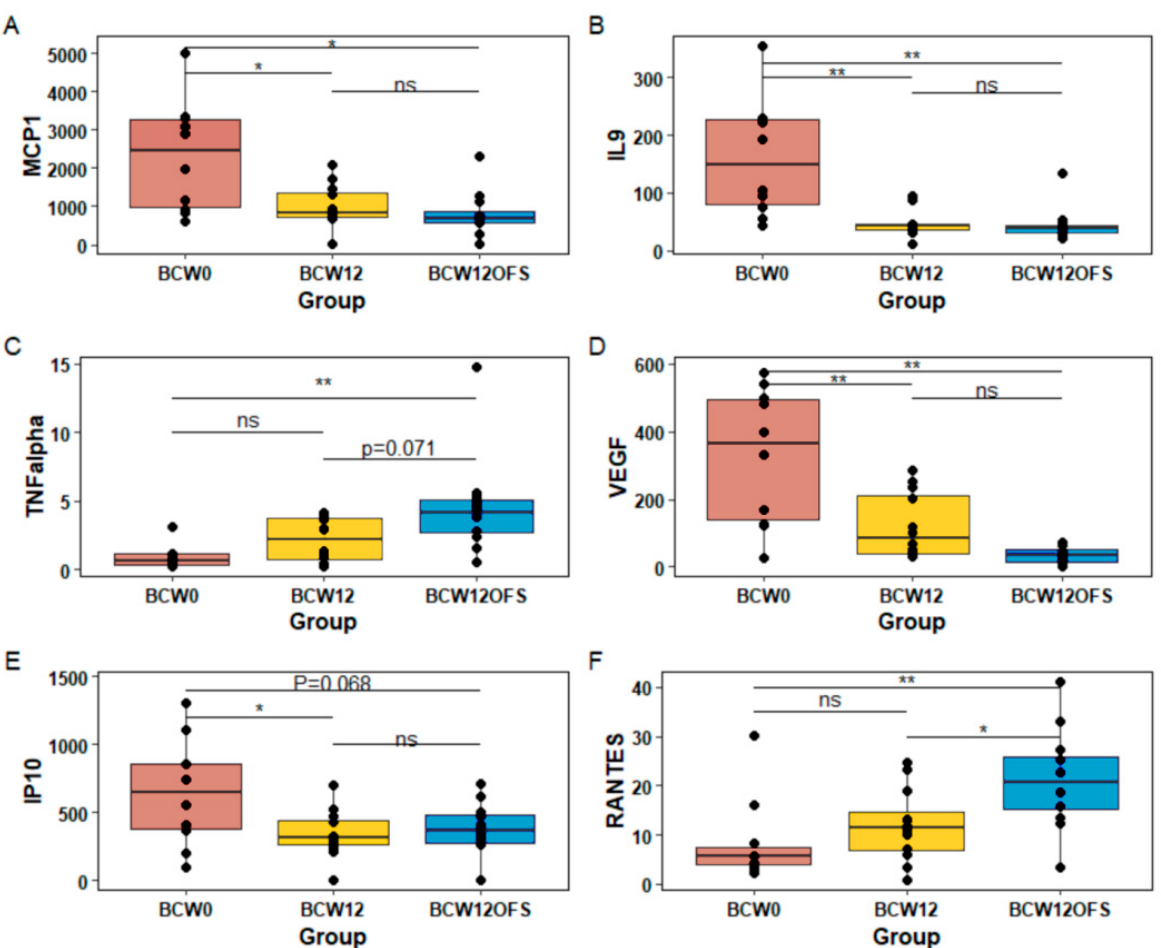
Figure 11. Levels of key tumor cytokines. Tumor cytokine levels as measured by multiplex assay which differed significantly between groups are presented ( A – F ). These include levels of MCP-1